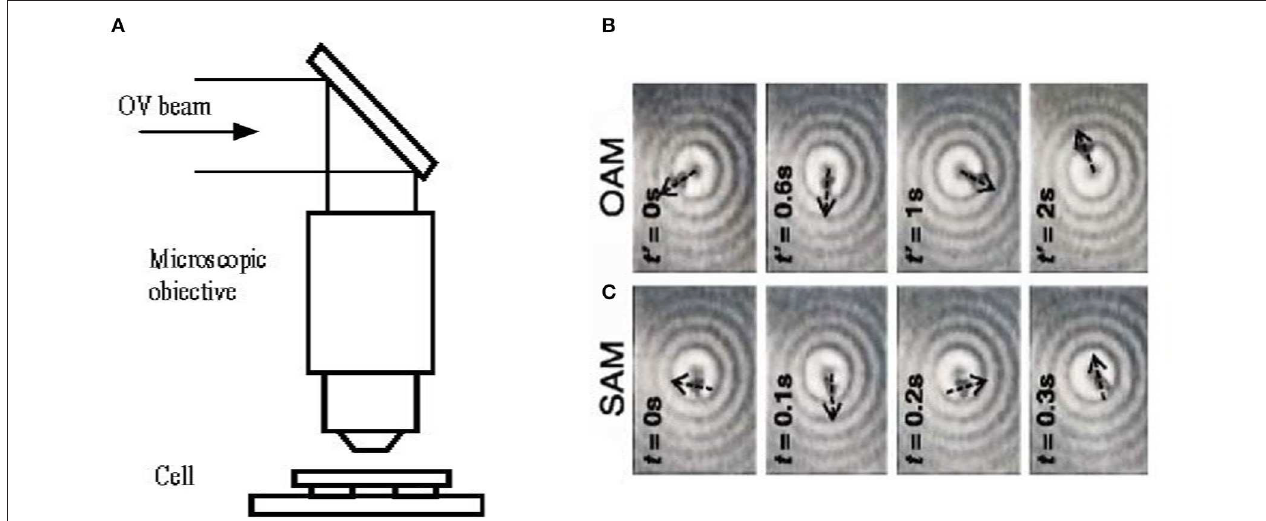
FIGURE 11 | (A) Optical system focusing the beam with OAM into the cell with suspended particles; (B,C) consecutive time-dependent positions and orientations of the particles in the objective focal plane under the action of the beam with (B) OAM, and (C) SAM [121].